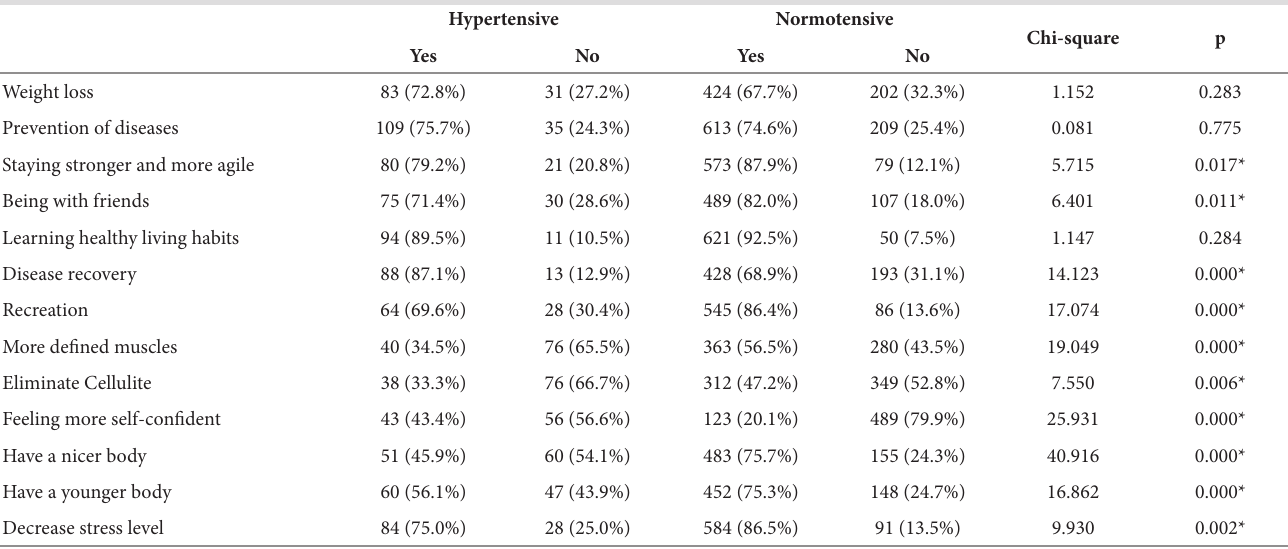
TABLE 1. Evaluation of the goals/expectations of participation in physical